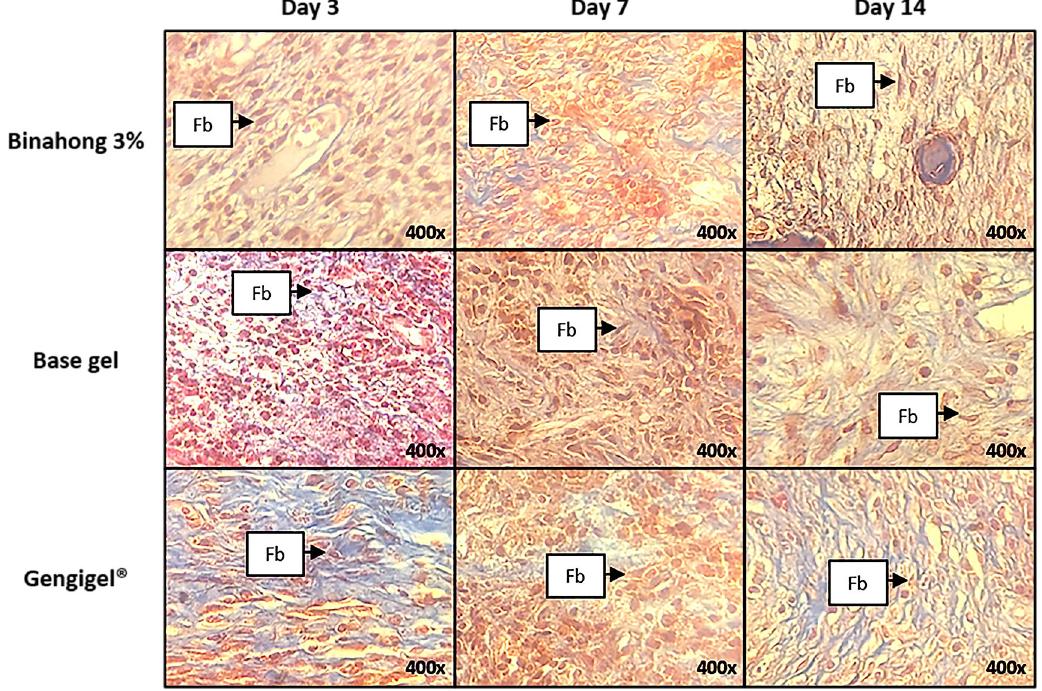
Figure 4. Histopathological observation of fibroblasts in the alveolar bone healing of sockets. The observation was conducted on the 3 rd , 7 th , and 14 th day post-extraction socket wounds stained with Masson ’ s Trichrome. (Abbreviation: Fb: Fibroblasts ( (cid:1)